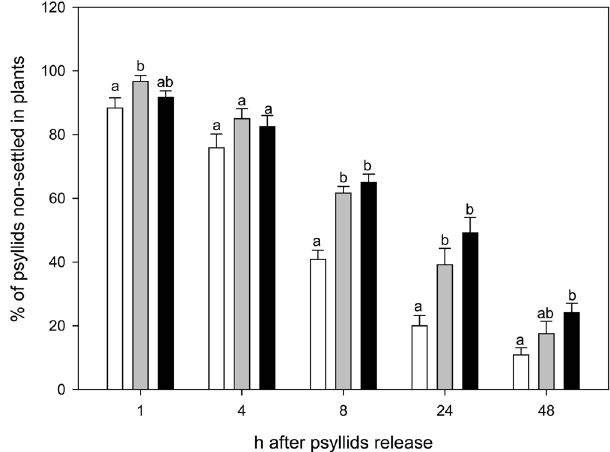
Figure 5. Percentage of D . citri psyllids non-settled in any plant (neither orange nor Arabidopsis ) 1, 4, 8, 24 and 48 h after their release when orange flushes were presented alone (white bars), caged with Arabidopsis At5g23960 KO line (grey bars) or caged with Arabidopsis At5g23960 OE line (black bars). For a given time, the bars with different letters indicate significant differences between the treatments tested ( * P < 0.1). Error bars represent SE (n = 12 independent tests, 10 responsive psyllids evaluated in each